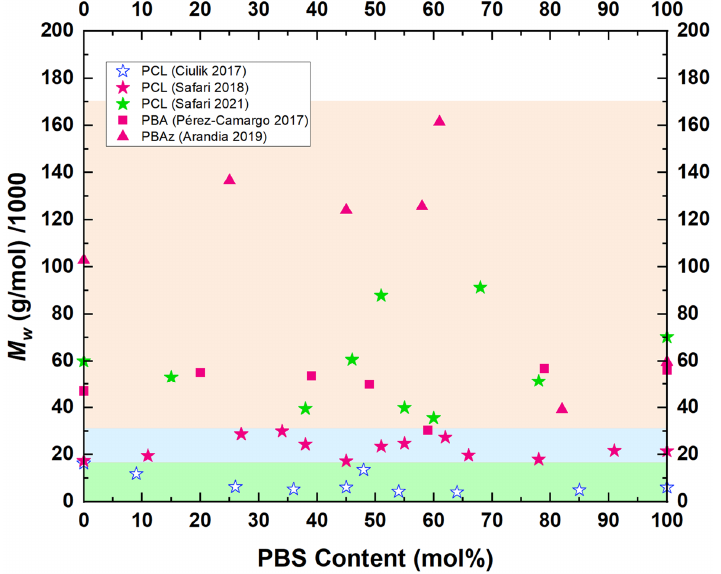
Figure 2. Variation of the weight average molecular weight (M w ) with PBS composition. The different comonomers are indicated in the legend. The green area corresponds to low-M w copolymers (obtained by enzymatic synthesis), the blue covers intermediate-M W copolymers, and the orange region indicates high-M W copolymers.